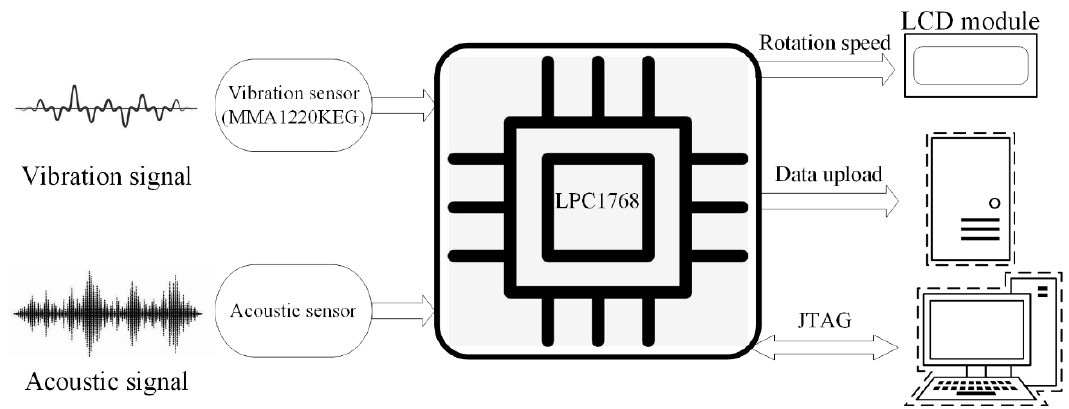
Figure 3. Diagram of the hardware structure. JTAG: Joint Test Action Group